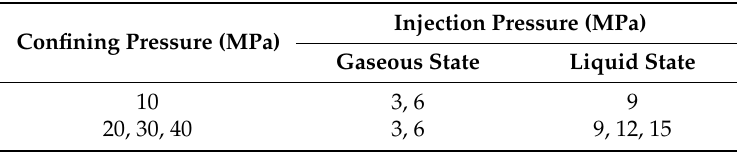
Table 3. Transient permeability test conditions.